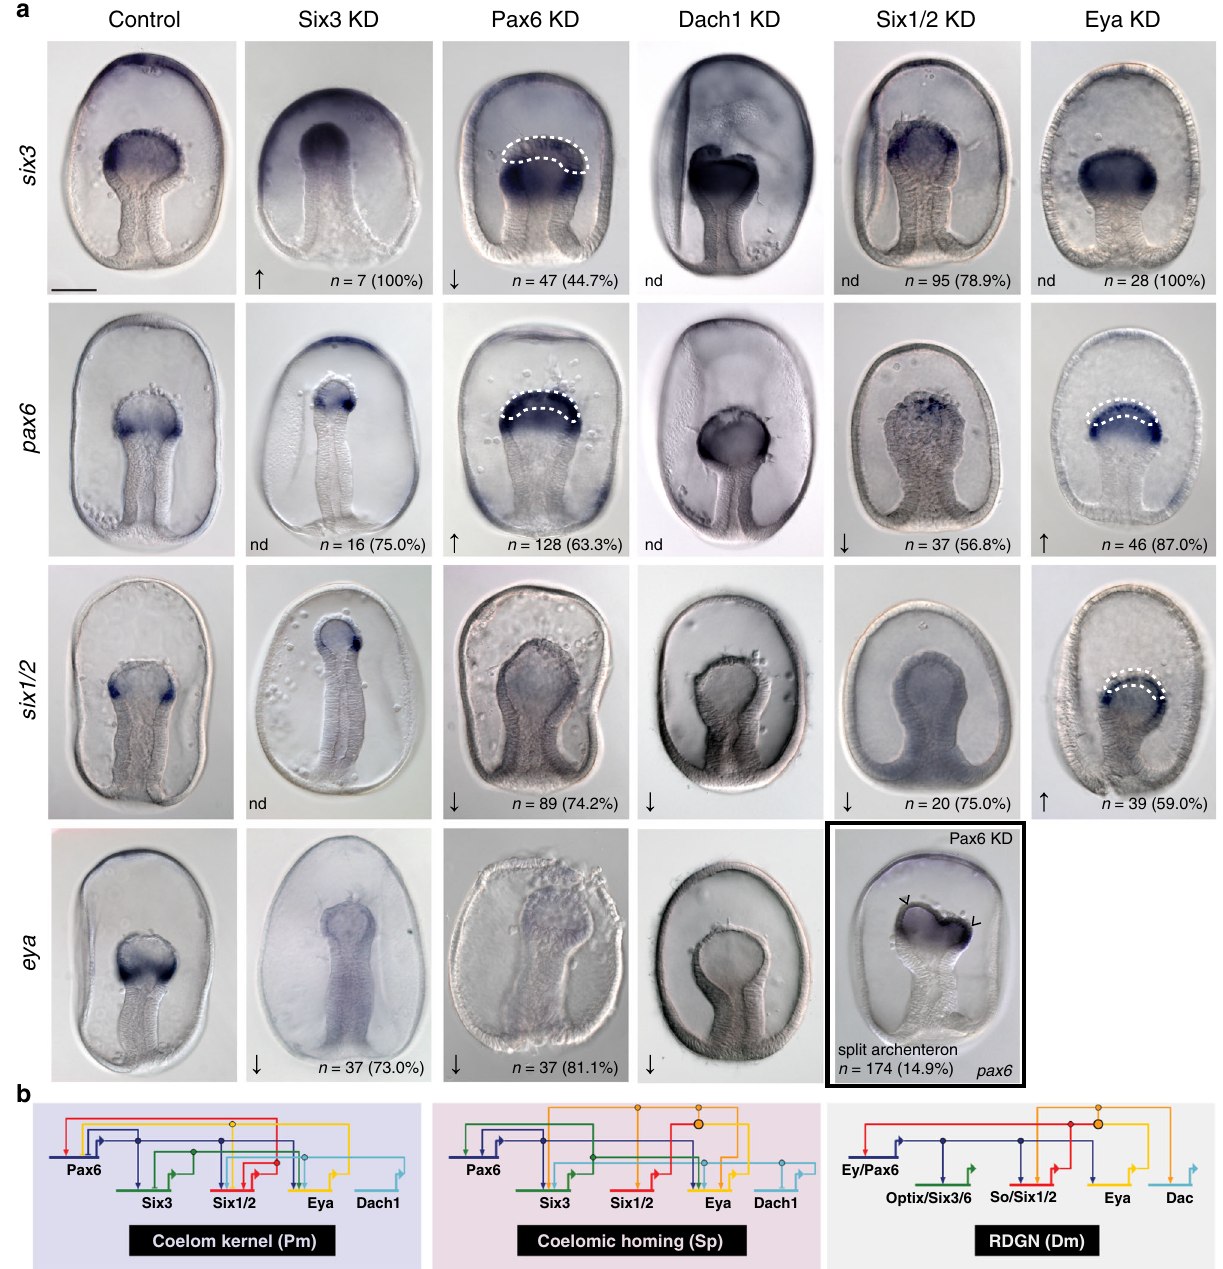
Fig. 5 Subcircuit including pax6 , six3 , eya , dach1 , and six1/2 involved in sea star coelomogenesis. a Data shown are colorimetric WMISH using the probes indicated on the left in the conditions listed along the top. Scale bar represents 50 μ m; applicable to all images in the panel. six3 expression is normally distributed throughout the mesodermal bulb of the archenteron at 48 hpf, while pax6 , six1/2 , dach1 , and eya are normally expressed at the posterior aspect of the mesodermal bulb, having been cleared earlier from anterior regions of the mesoderm. Phenotypic effect of the perturbation of each gene is indicated, including no difference (nd), increase ( ↑ ), decrease ( ↓ ). The number of embryos assessed and percent of embryos expressing the phenotype are also reported. Some reported phenotypes are localized to the top of the archenteron and are highlighted (dashed line); e.g., the effect of Pax6 knockdown on six3 expression is reported speci fi cally for the anterior region of archenteron (dashed line). Some Pax6 knockdown embryos exhibited a bifurcated archenteron (e.g., boxed panel, “ split archenteron ” ). Data are representative of two biologically independent experiments consisting of at least ten embryos each and speci fi c phenotype counts are detailed in Supplementary Table 3. These results enabled the construction of a sub-network for sea star coelomic epithelium ( b ) and we note a similar regulatory sub-network in both sea star and sea urchin coelomic mesoderm, which is strikingly similar to the retinal determination gene network (RDGN) in